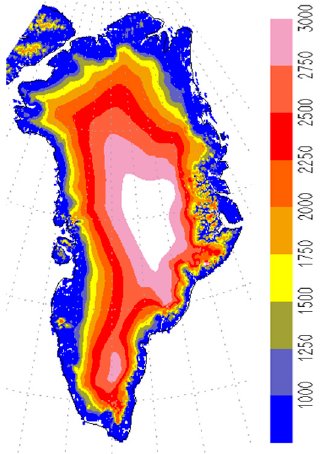
Figure 13. Elevation (m) from the elevation product of the National Oceanic and Atmospheric Administration (NOAA).